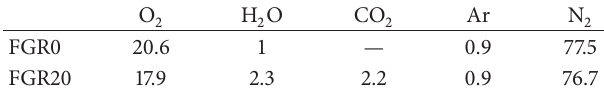
Table 2: Composition (vol, %) of oxidizer stream.